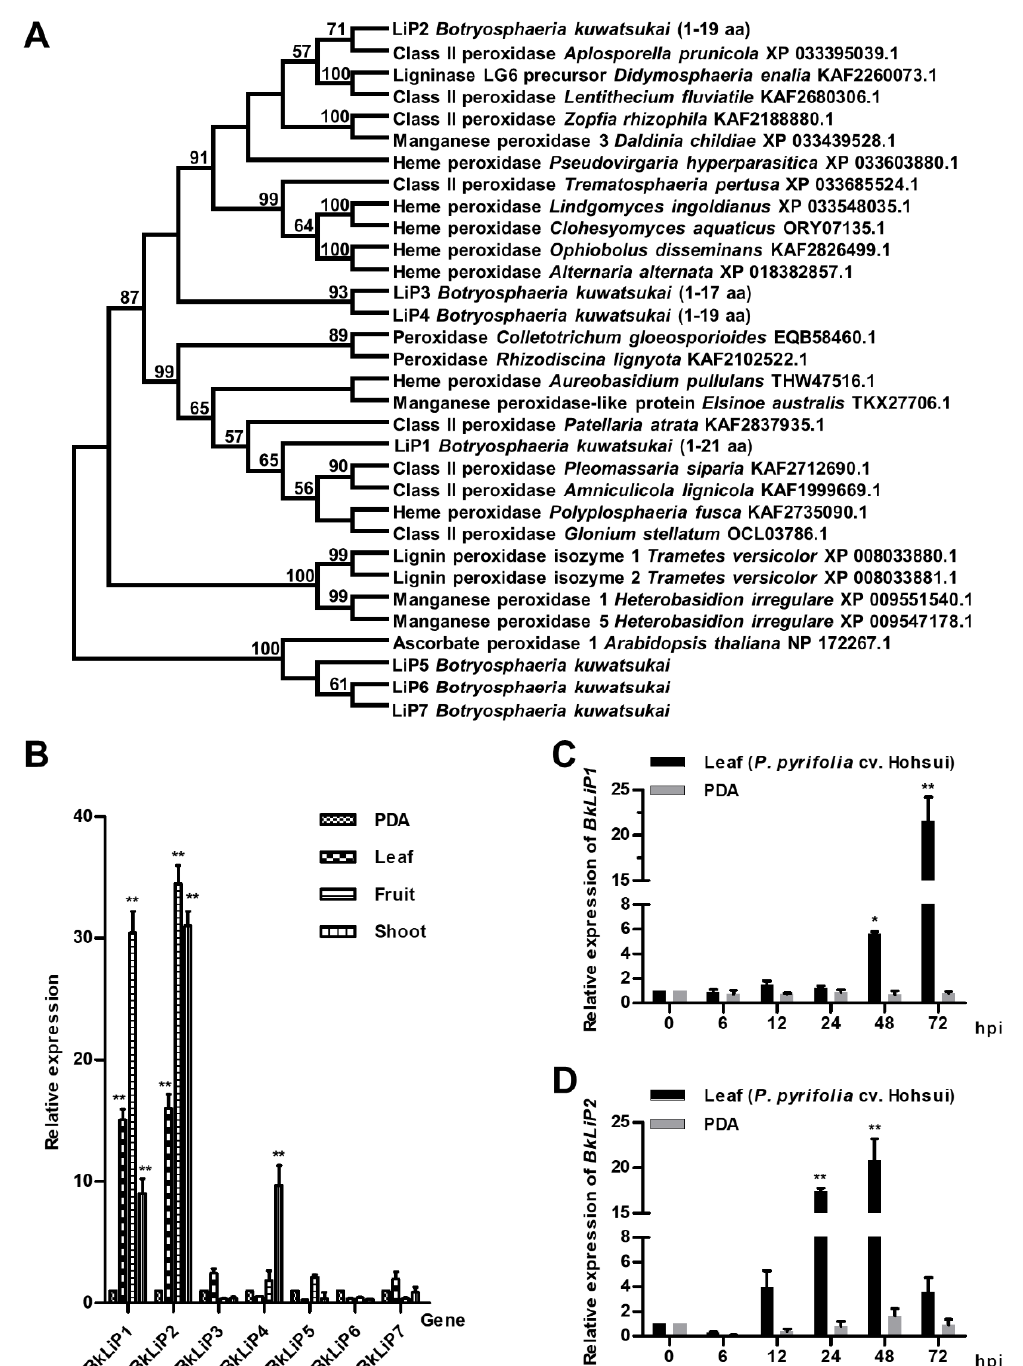
Figure 1. Phylogenetic analysis and induced expression of lignin peroxidase ( LiP ) genes in Botryosphaeria kuwatsukai . ( A ) The evolutionary relationship of LiP orthologs in B. kuwatsukai and other fungi determined with the maximum-likelihood algorithm. The statistical strengths were assessed